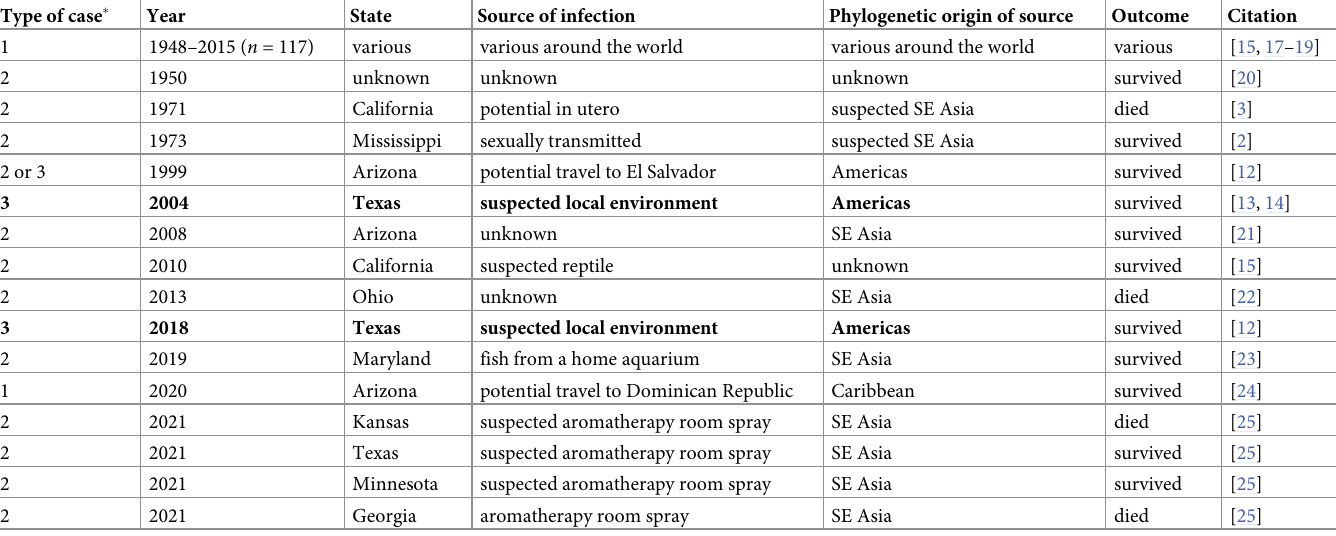
Table 1. Published melioidosis cases reported from the CONUS since 1948 (excluding laboratory acquired infections).